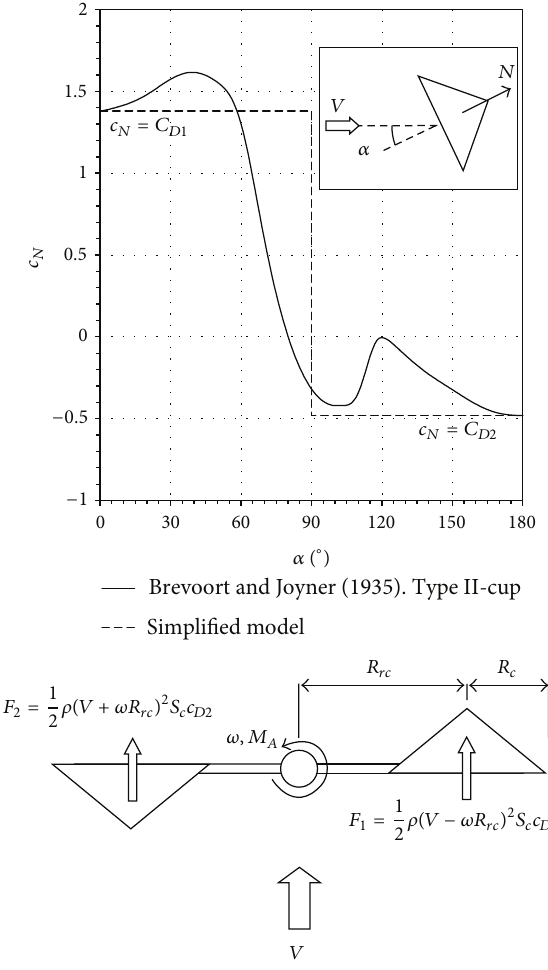
Figure 4: Normal aerodynamic force coefficient, 𝑐 𝑁 , of the Brevoort and Joyner Type-II cup [27], plotted as a function of the wind direction with respect to the cup, 𝛼 . The approximation used in the classical simplified model for aerodynamic torque on the anemome- ter rotor (expression (11)) is also included as a dashed line. See in the attached sketch the idealized approximation to the equilibrium point of the 2-cup analytical model, where 𝑀 𝐴 = 0 , 𝐹 1 = 𝐹 2 , and, therefore, the rotation speed 𝜔 is